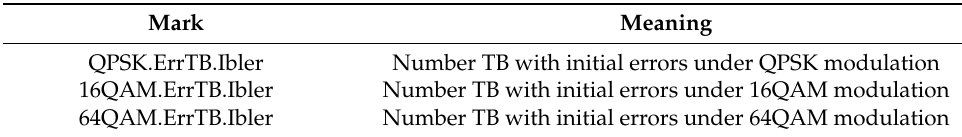
Table 4. Values by which the iBLER value is